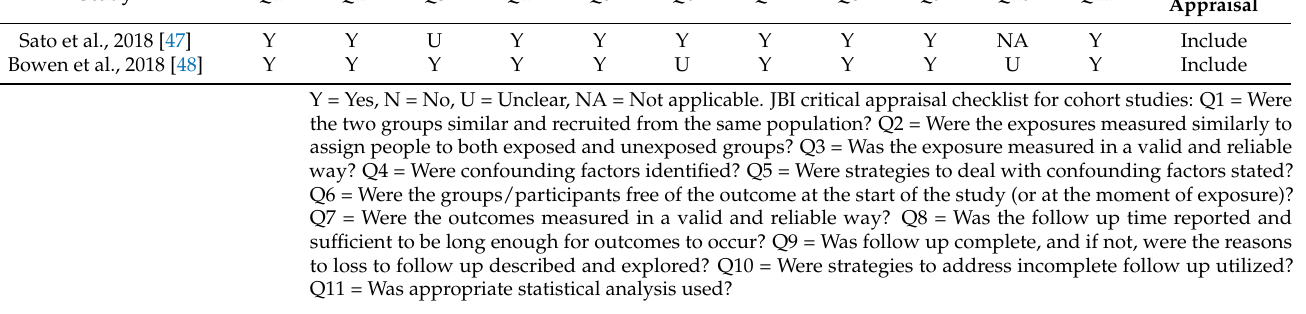
Table A10. The methodological quality assessment results of analytical cross-sectional